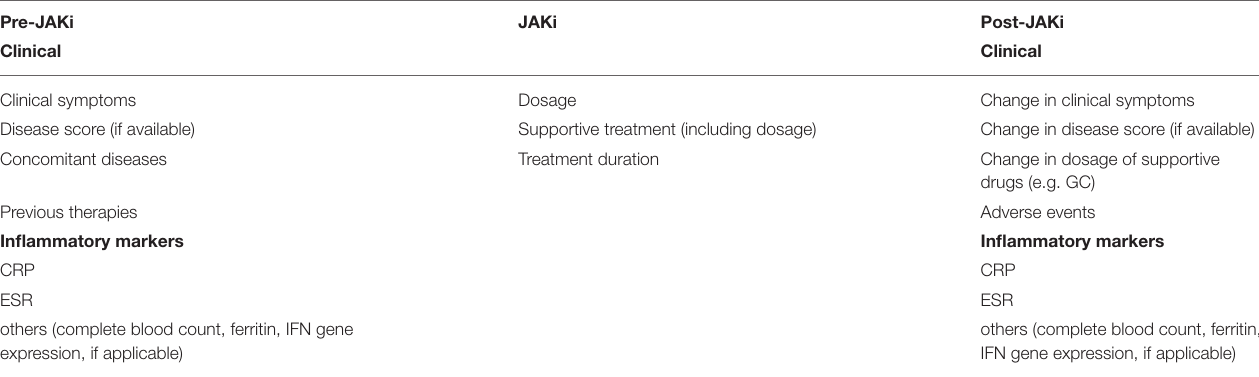
TABLE 3 | Suggestions for future reporting on treatment outcome.